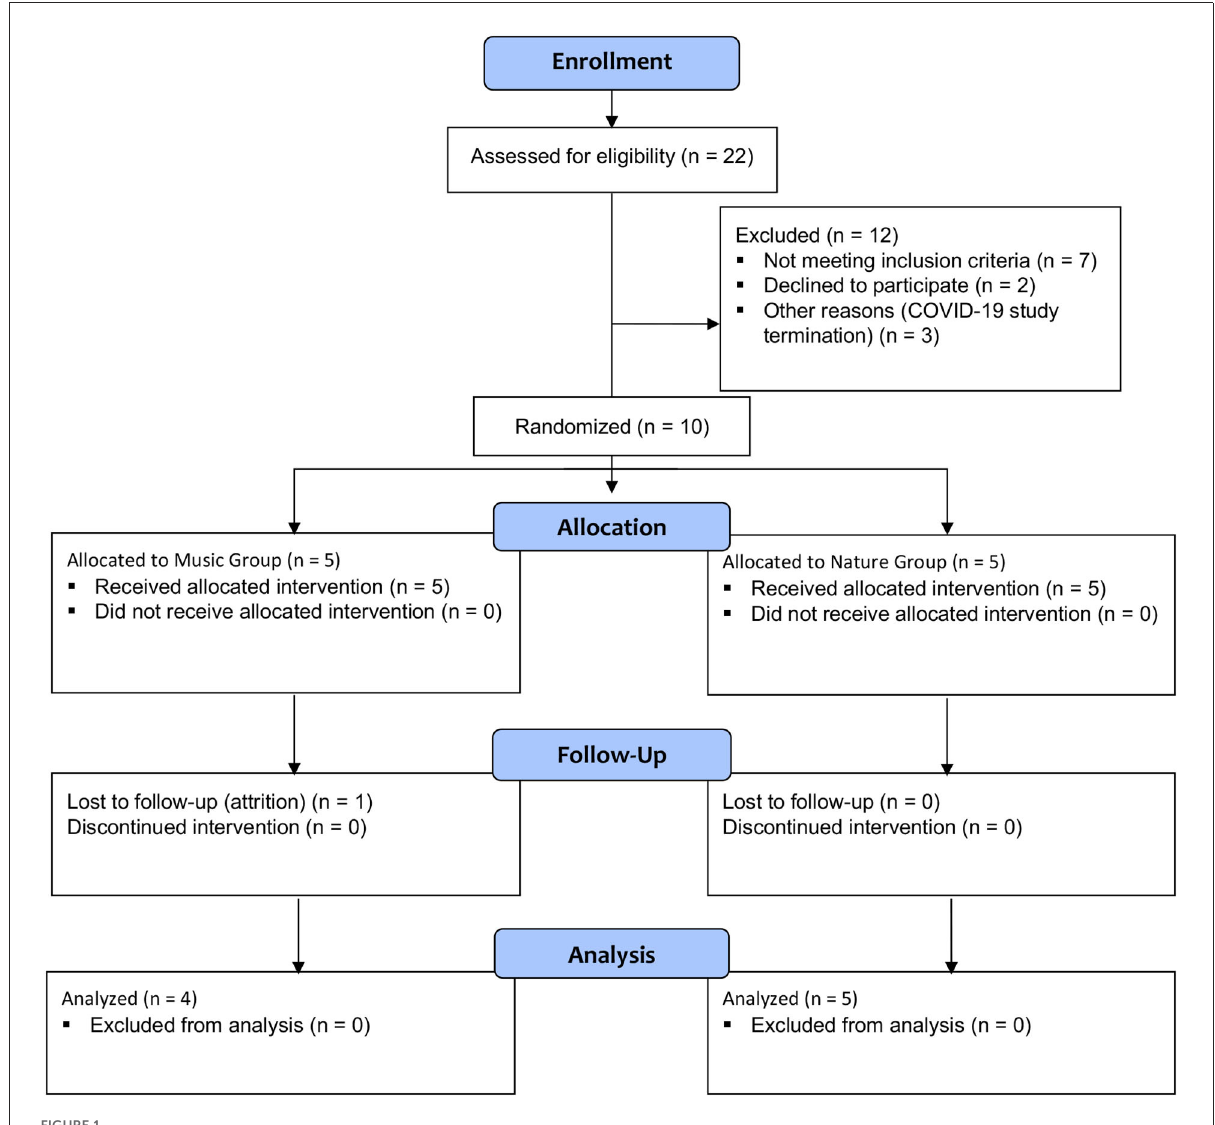
FIGURE1 CONSORT 2010 flow